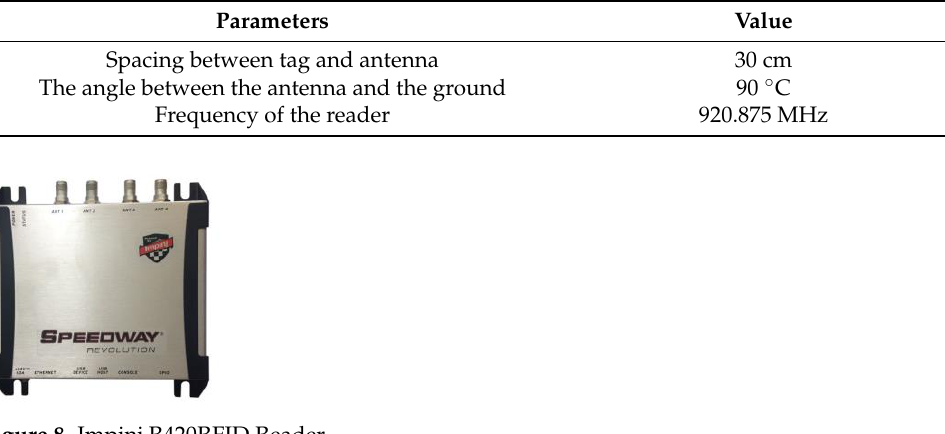
Figure 8. Impinj R420RFID Reader.